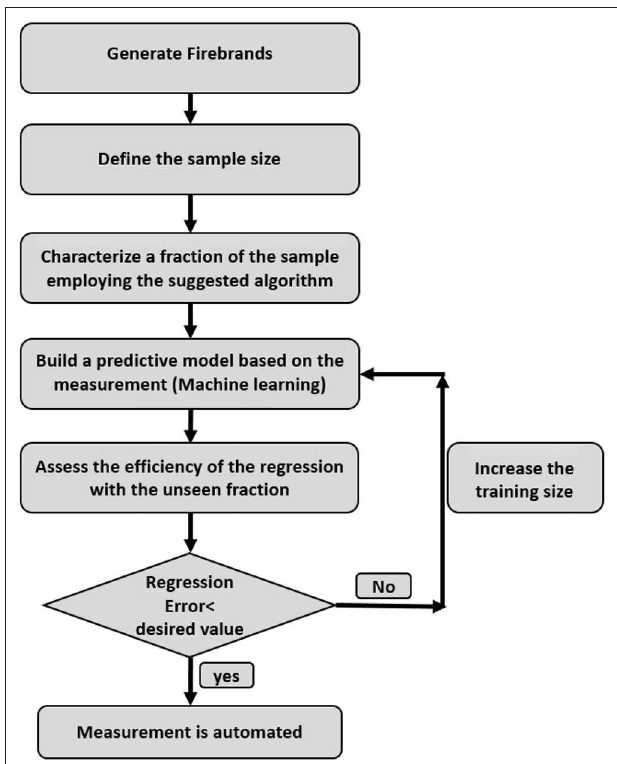
FIGURE 1 | The overview of the